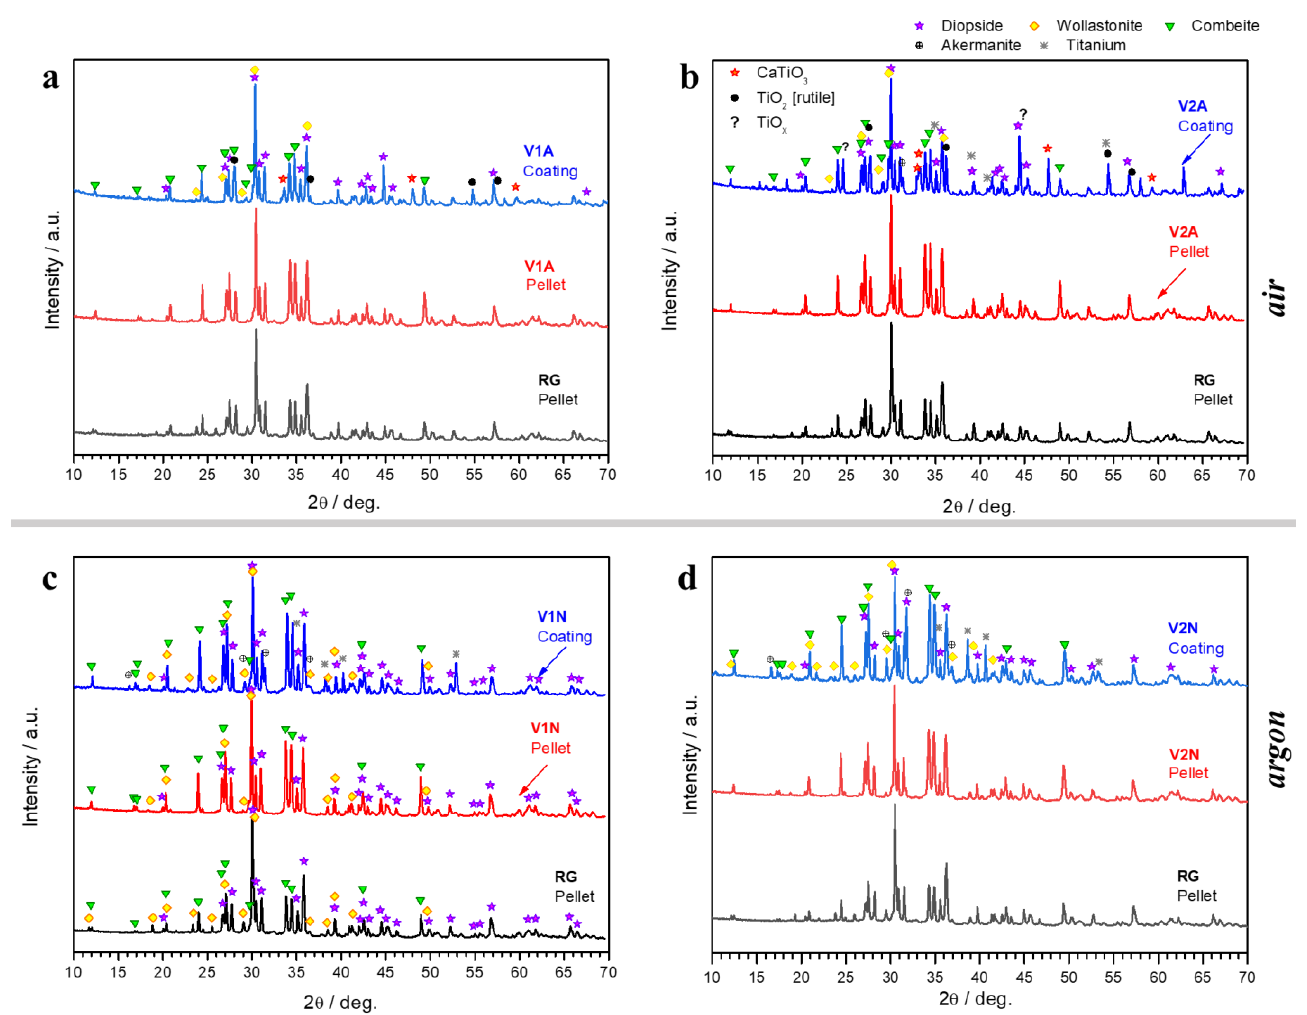
Figure 4. Comparison of XRD patterns of glass–ceramic coatings (deposition time: 1.5 s) from V1 and V2 glasses reacting with H44 silicone in air ( a , b ) and in argon atmosphere ( c , d ), compared with pellets fired under the same conditions.